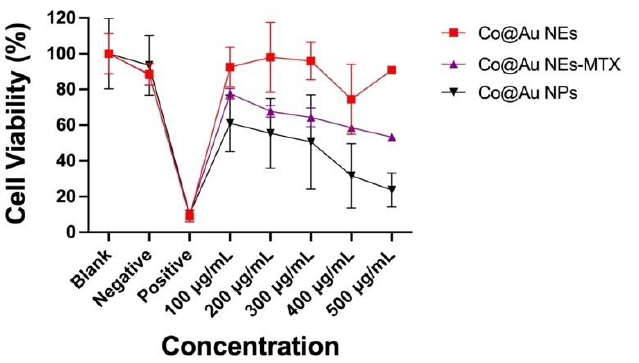
Figure 5. Cytotoxicity analysis of round Co@Au nanoparticles (Co@Au NPs) and elliptical Co@Au (Co@Au NEs) nanoparticles. Cell viability of L929 fibroblasts cultured in varying concentrations of Co@Au NPs, Co@Au NEs and Methotrexate (MTX)-conjugated Co@Au NEs-MTX., 0.1 g Teflon was used a negative control and 0.1 g latex was used as a positive control and only cell culture media (DMEM) was used as a blank.